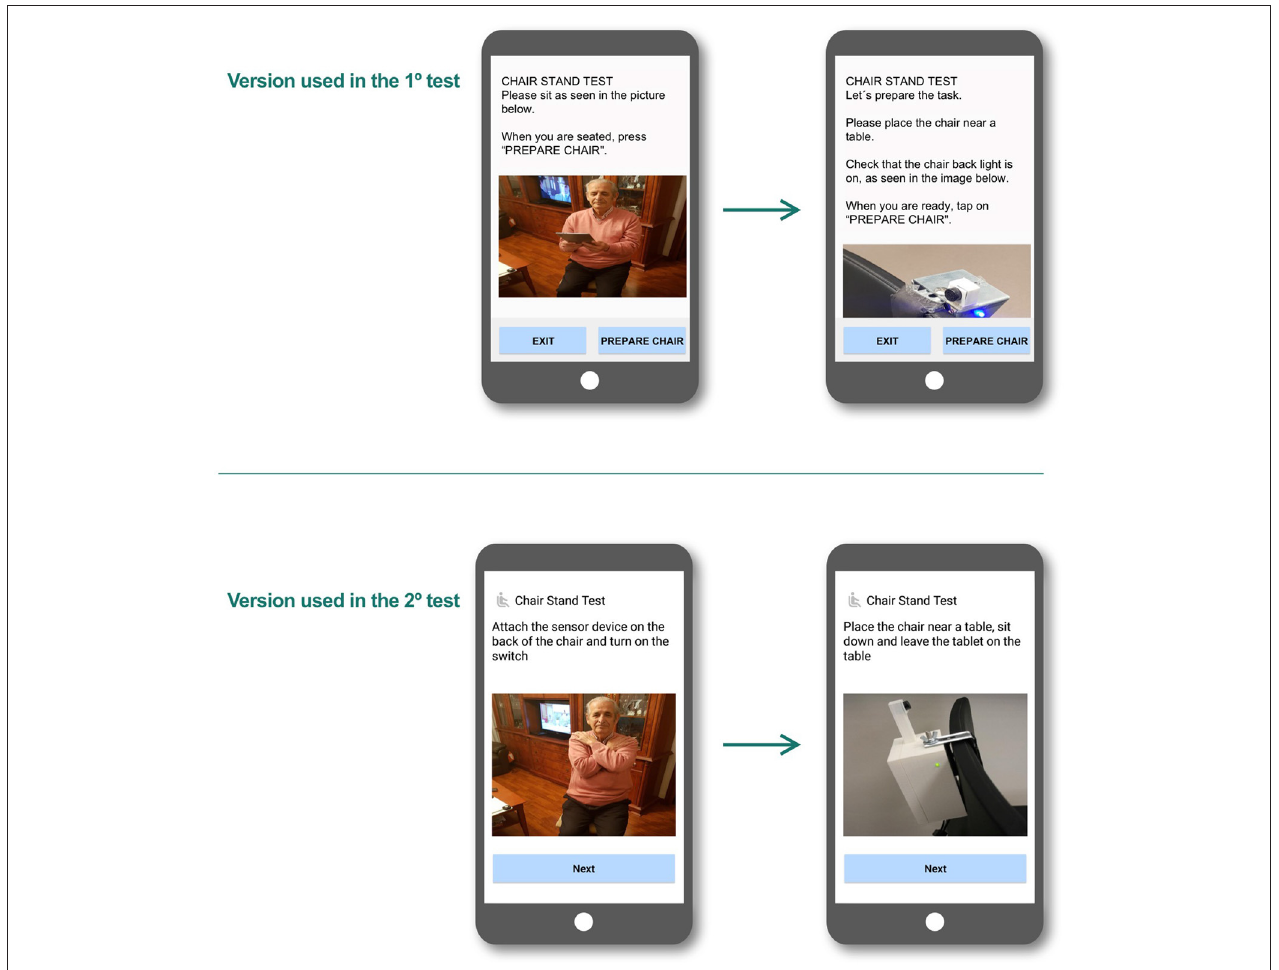
FIGURE 3 | Changes in the mobile app to reduce